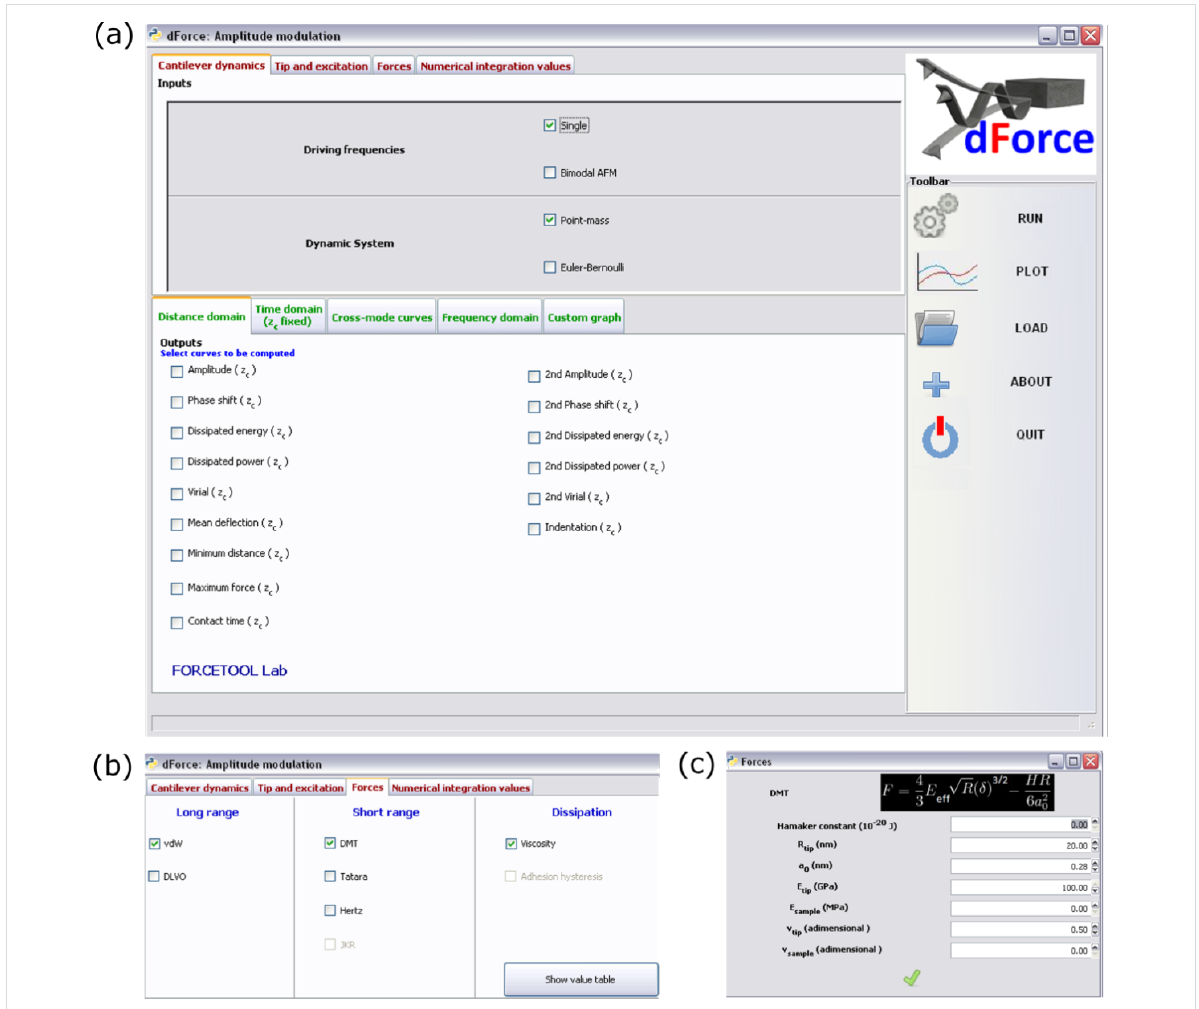
Figure 1: Graphical user interface of dForce. (a) Main menu. It is divided in three sections, two horizontal and one vertical. The top tabs contain all panels relevant for AFM simulations. The bottom panel enables selection of the output plots. The vertical panel contains the tabs for running the program and managing the output. (b) Force panel that shows the different tip–surface force models implemented in dForce. (c) Example of the input panel for the DMT